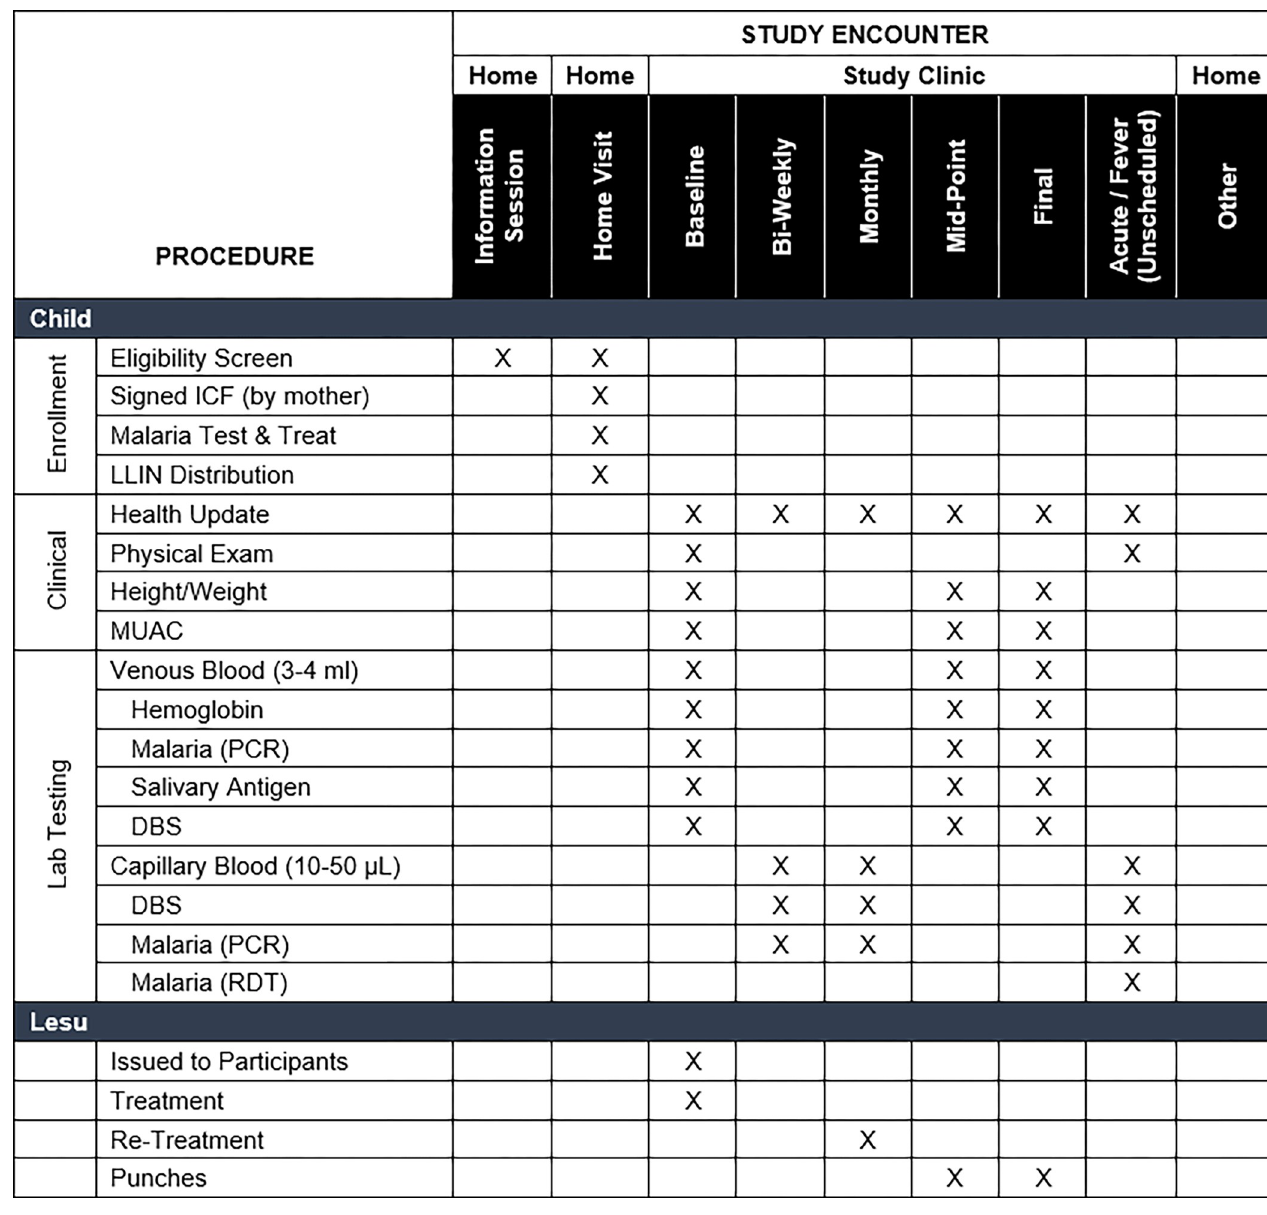
Fig 2. Modified SPIRIT checklist for participating